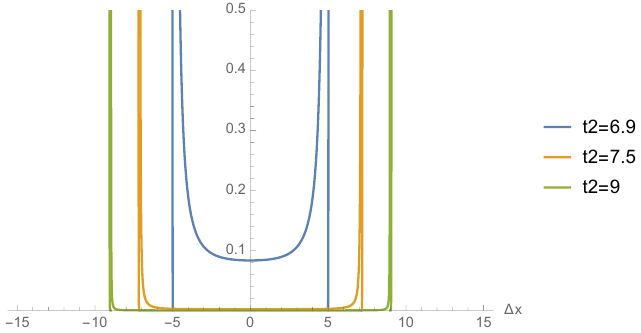
Figure 8 . This shows the profile of the commutator for t 1 = 2 T c on constant t 2 slices as a function of ∆ x . Note how the commutator vanishes more rapidly as t 2 is